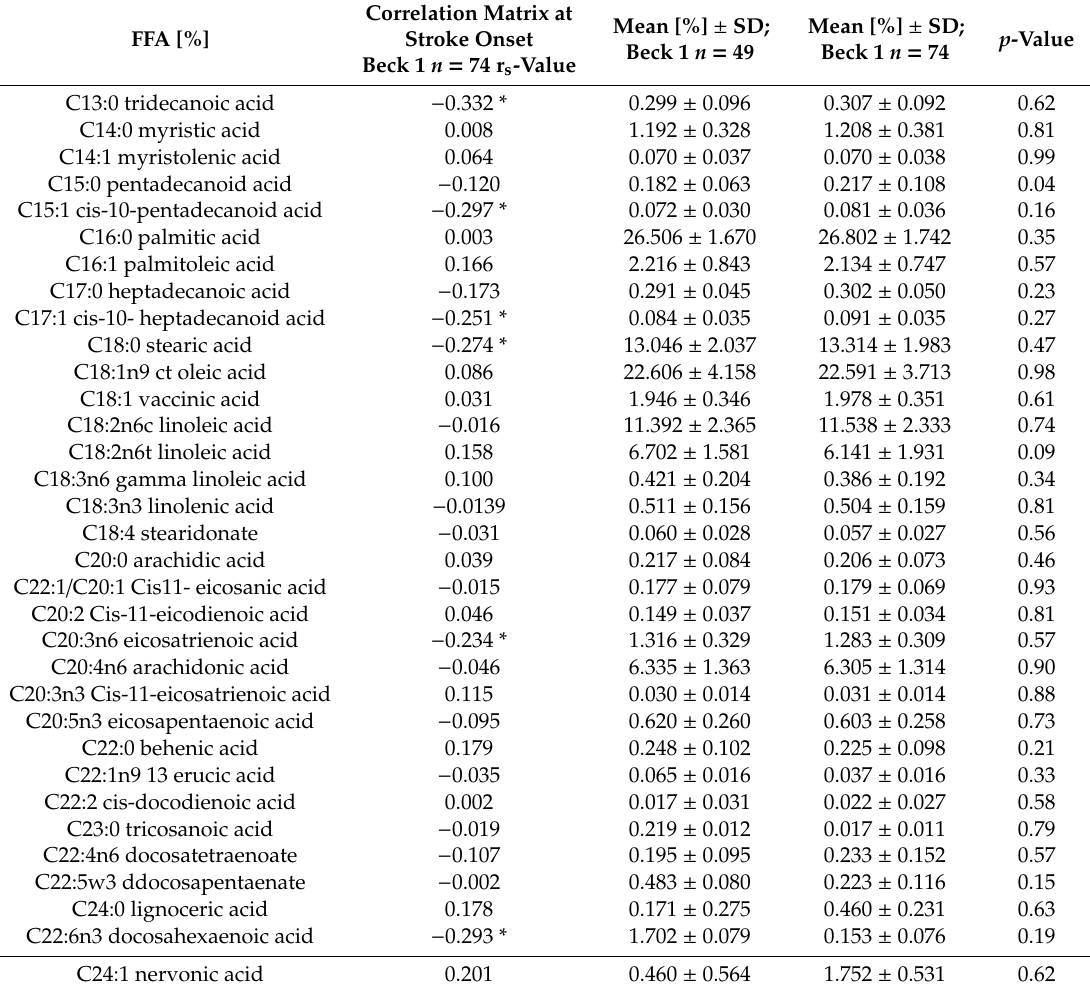
Table 2. Association between free fatty acids (FFAs) and BDI-II score obtained on 7th day (Beck 1) and comparison of free fatty acids (FFAs) mean values between